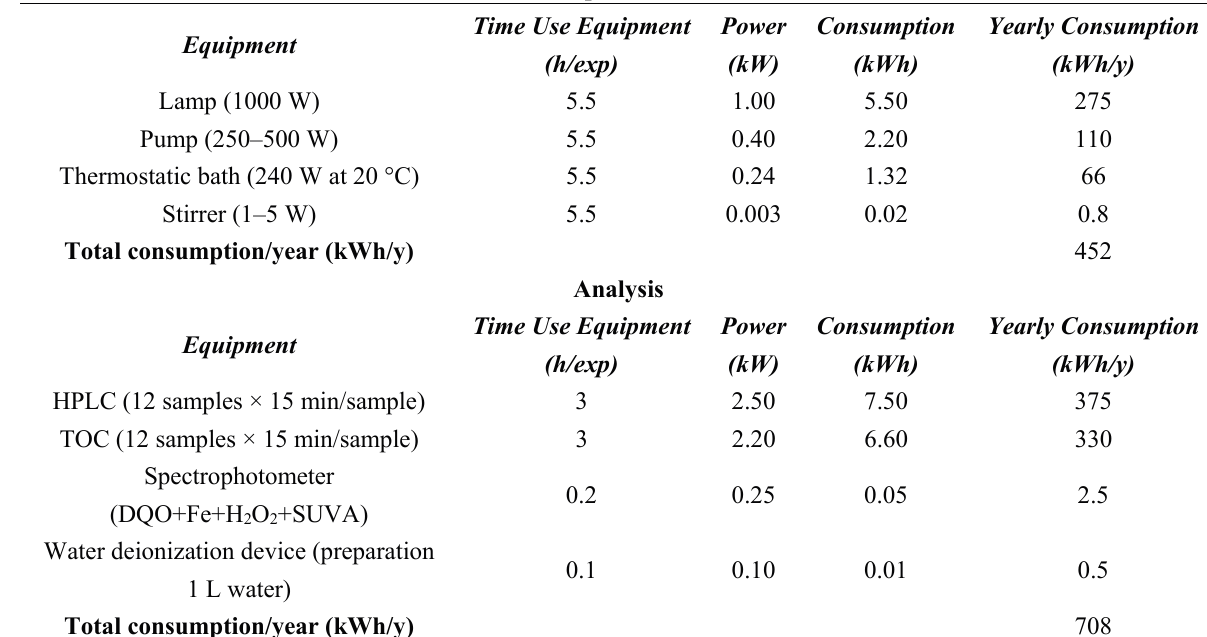
Table 5. Electricity consumption in MET photocatalytic treatment experiments in a Solarbox for 50 experiments/year.